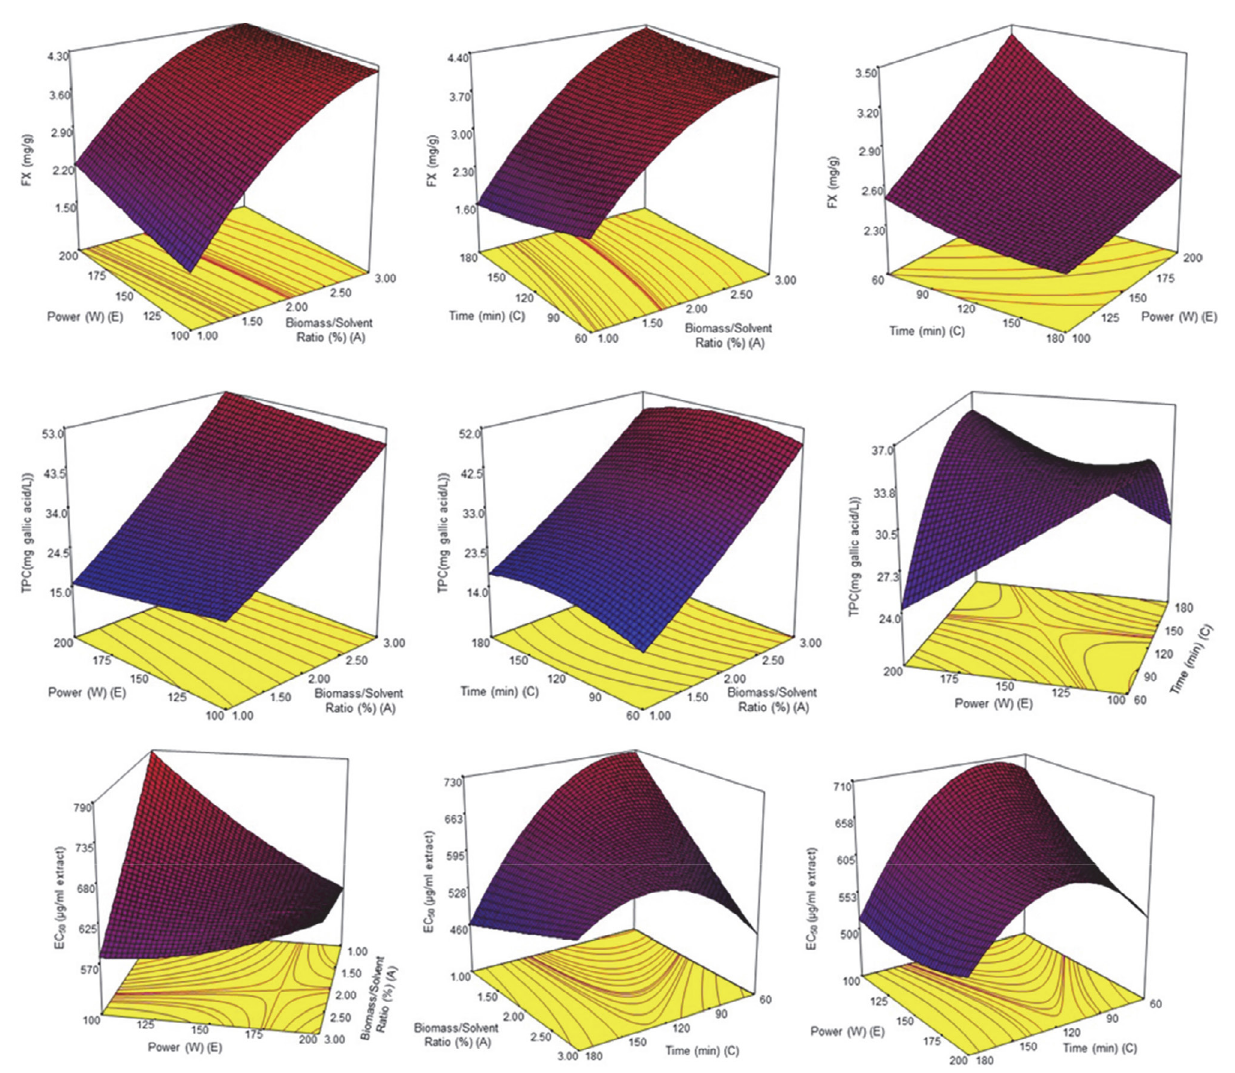
Figure 3. Calculated effects of microwave extraction process variables on fucoxanthin content (mg/g), total phenolic content (mg gallic acid /L) and antioxidant activity (EC 50 µg/mL